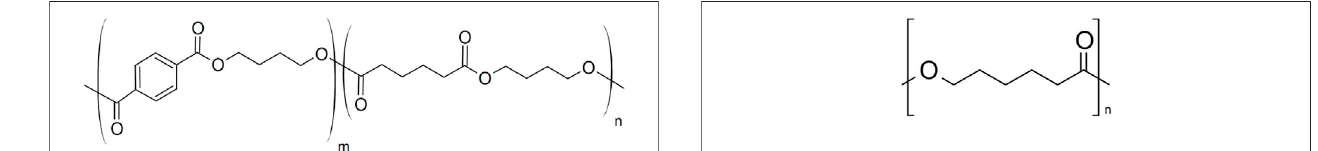
FIGURE 5 | Chemical structure of poly( ε